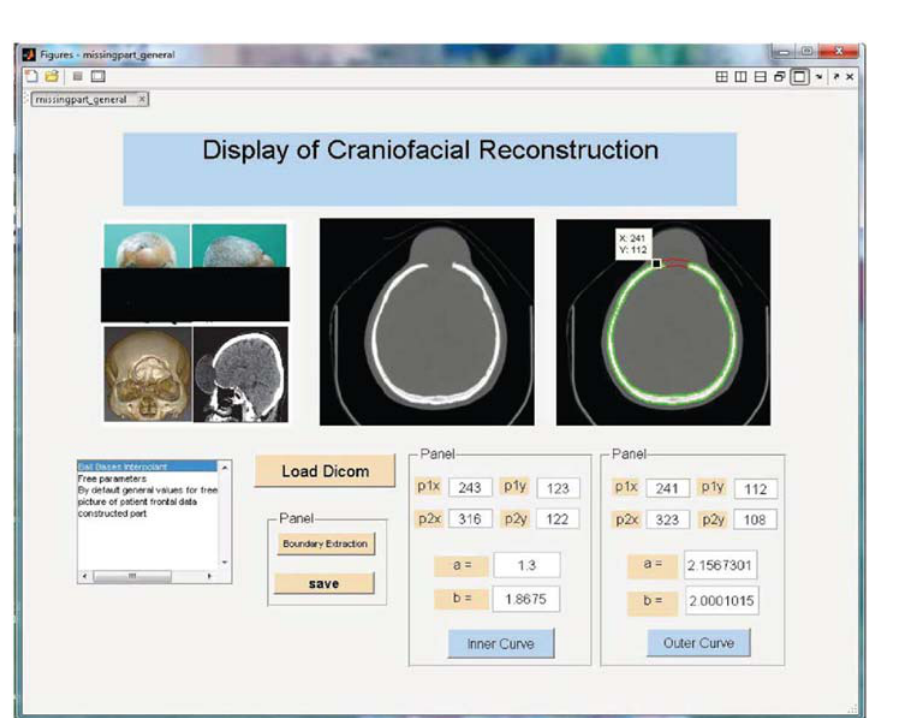
Fig 14. GUI display of craniofacial